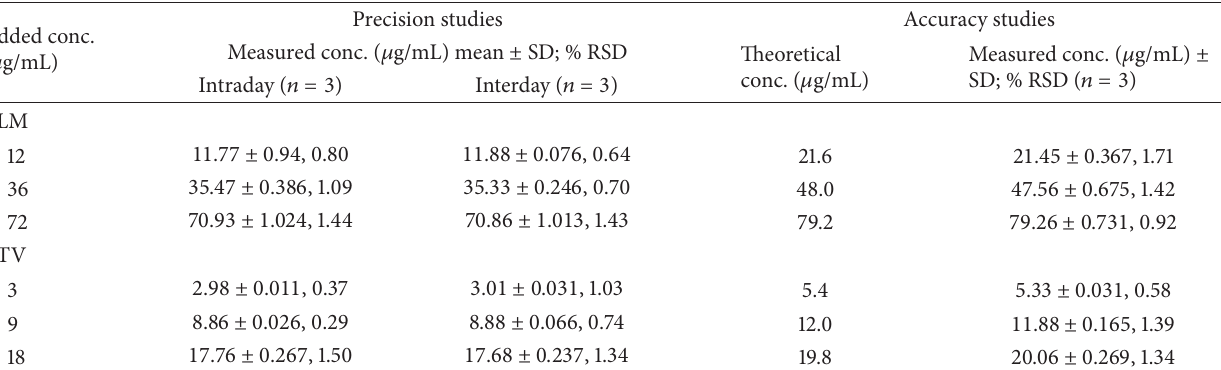
Table 2: Intraday and interday precisions and accuracies by HPLC